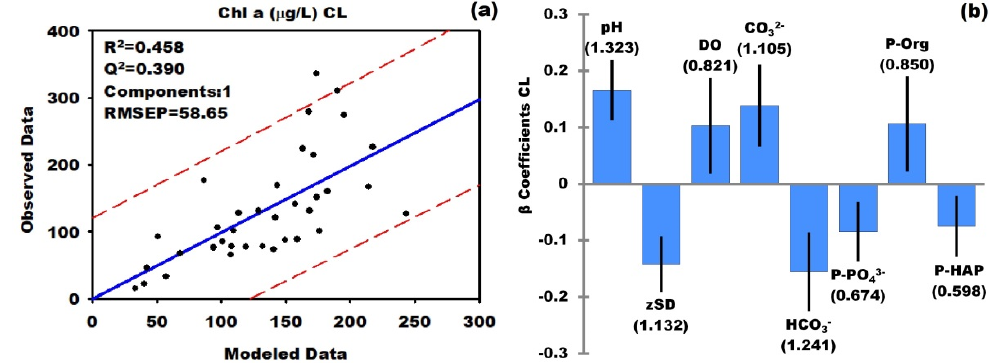
Figure 4. ( a ) CL Chl a modeled vs. observed data, regression line (solid line), 95% prediction confidence intervals (dashed lines), and model performance metrics; ( b ) CL β coefficients for retained variables (bars), confidence intervals (solid lines), and VIP in parentheses.